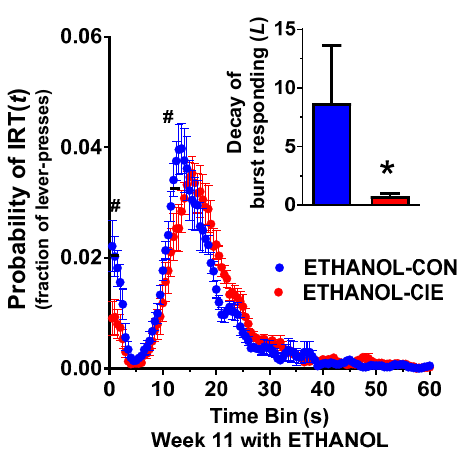
Figure 4. Interresponse time (IRT) distribution during DRL15 at Week 11 was modified in the ETHANOL-CIE group, such that response inhibition increased compared with the ETHANOL-CON group. (Inset) Mathematical modeling revealed that the ETHANOL-CIE group (red) exhibited a smaller rate of decay of burst responding compared with the ETHANOL-CON group (blue). The data are expressed as the mean ± SEM for percent reinforcers earned/responses emitted. n = 7–8/group; # p < 0.05, compared with IRT in ETHANOL-CON group at corresponding time bin; * p < 0.05, compared with corresponding CON group (inset).